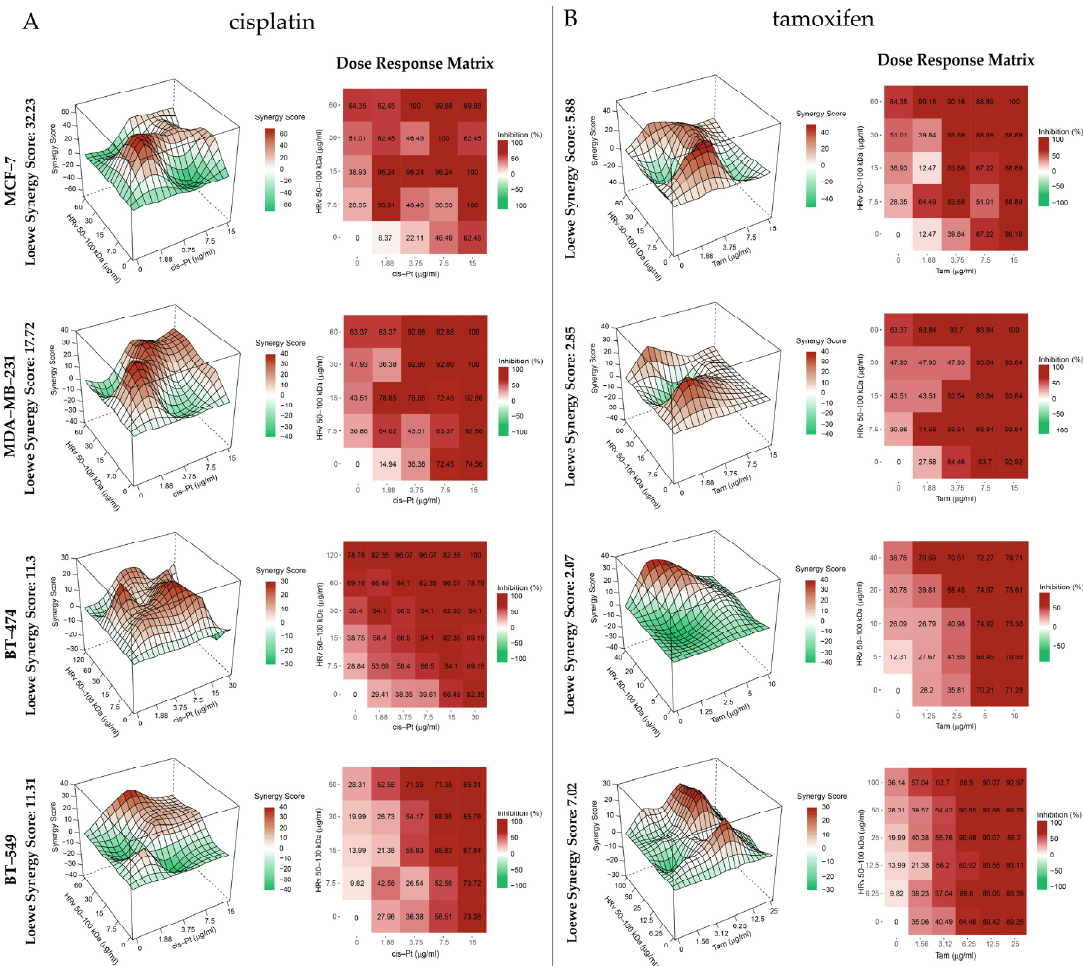
Figure 5. Combination landscapes and dose–response matrices in different cell lines treated with hemolymph fraction of R. venosa 50–100 kDa and cisplatin ( A ) or tamoxifen ( B